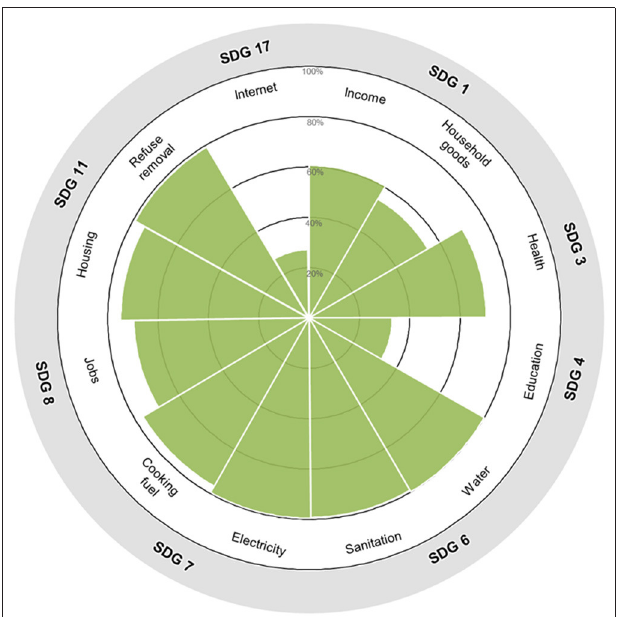
FIGURE 5 | SDG barometer for all Far West Rand